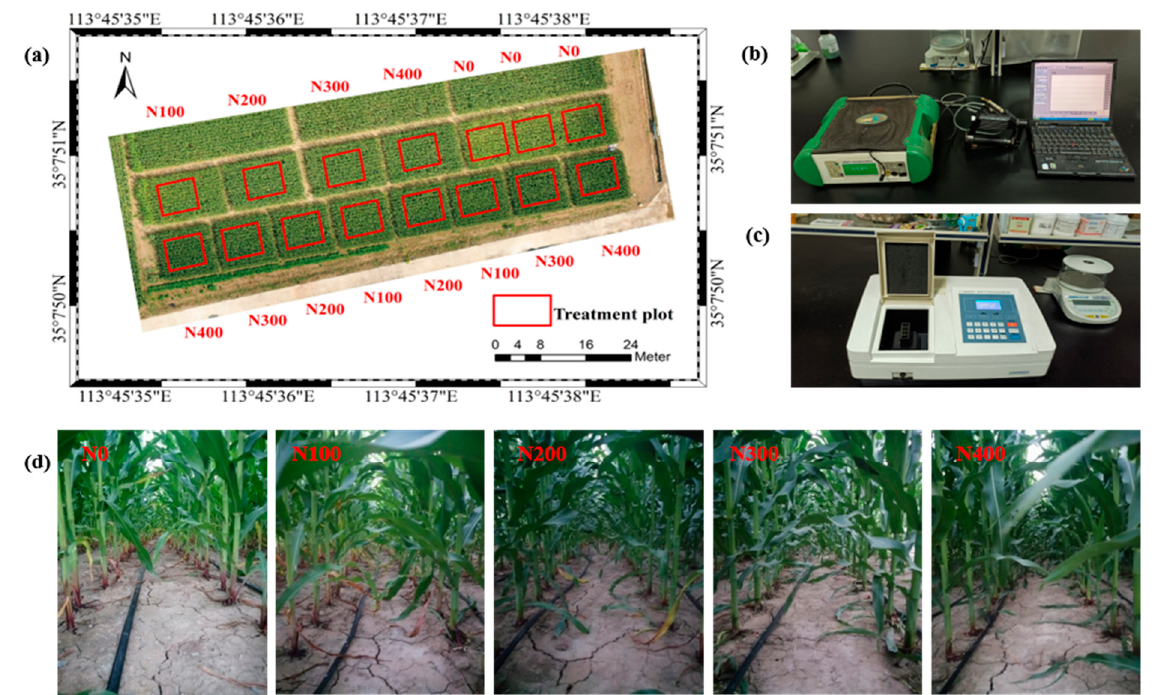
Figure 1. Overhead view of the study area on 2 September 2020 ( a ). Hyperspectral reflectance measurement system ( b ). Benchtop chlorophyll spectrophotometer ( c ). Canopy conditions under five nitrogen treatments (N) on 8 August 2020 ( d ).